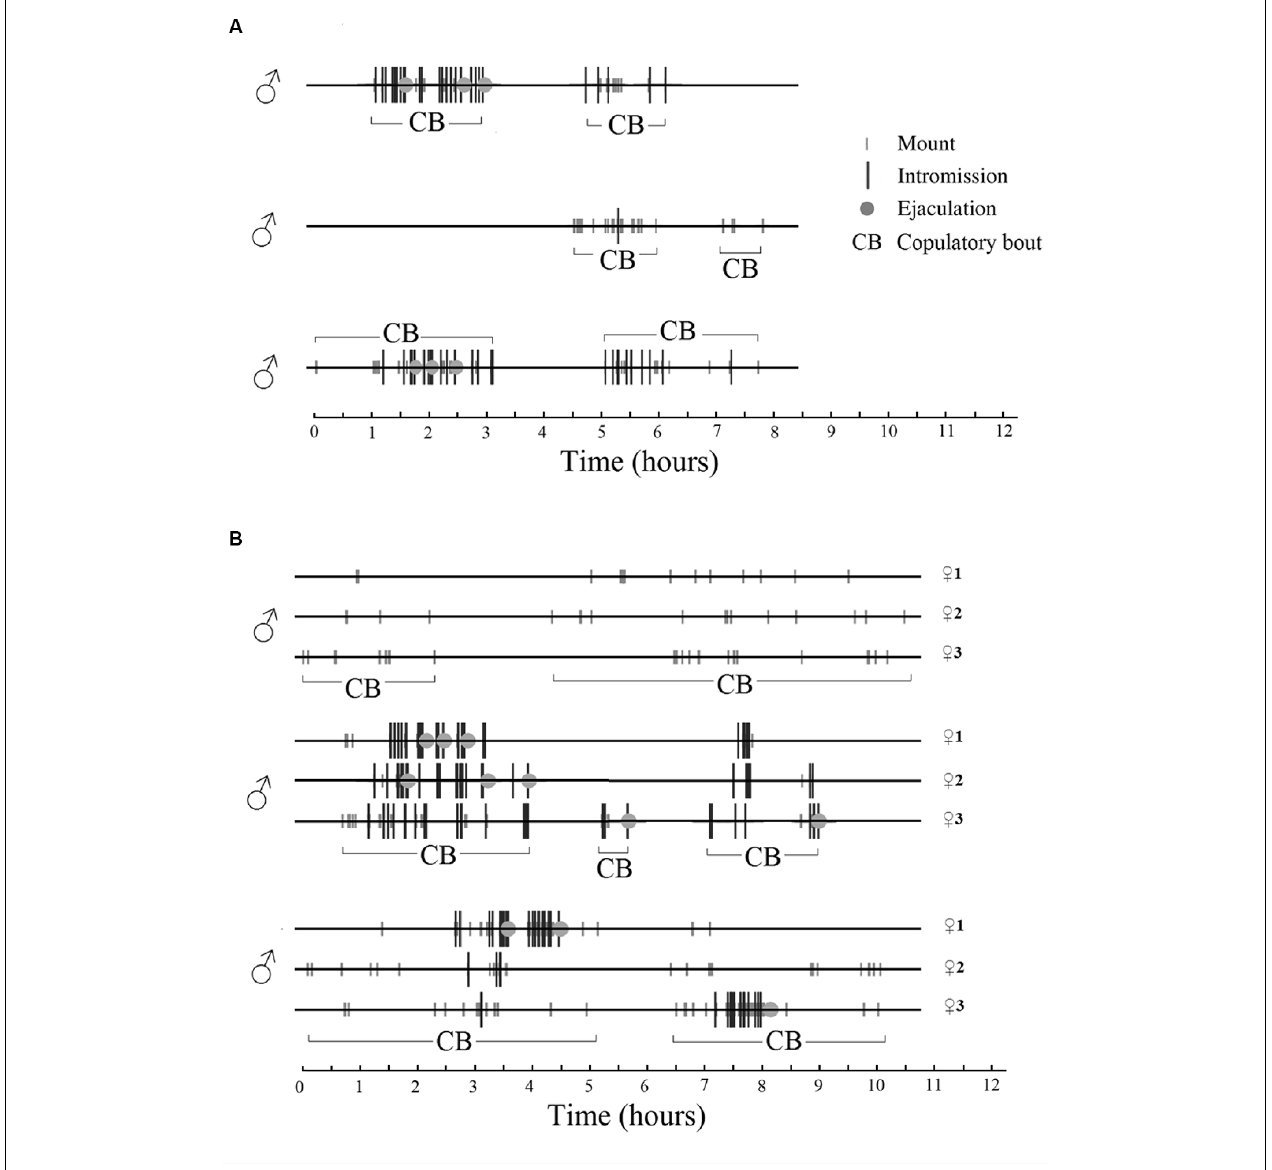
FIGURE 4 | Sexual behavior displayed by male rats in a seminatural environment during females’ natural estrus. There were three males in the environment. Time 0 represents the beginning of estrus, i.e., when the female or females presented their first lordosis. A copulatory bout (CB) is a period of continuous (adjacent copulatory events are separated by less than 60 min) male sexual activity. (A) One single female is in estrus. All males copulate with the female during overlapping periods. (B) Three females are in estrus simultaneously. Each male copulates with the three females, and each female copulates with all the males in